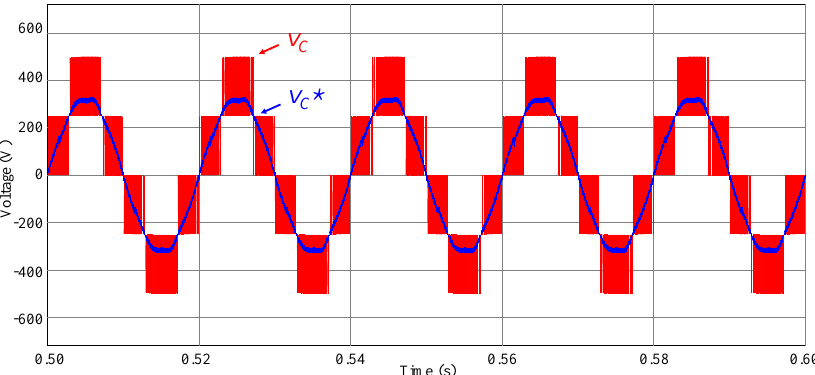
Figure 8. Simulation results of the modified multilevel SPWM modulation technique: Converter reference voltage ( v c *) and converter voltage ( v c ).